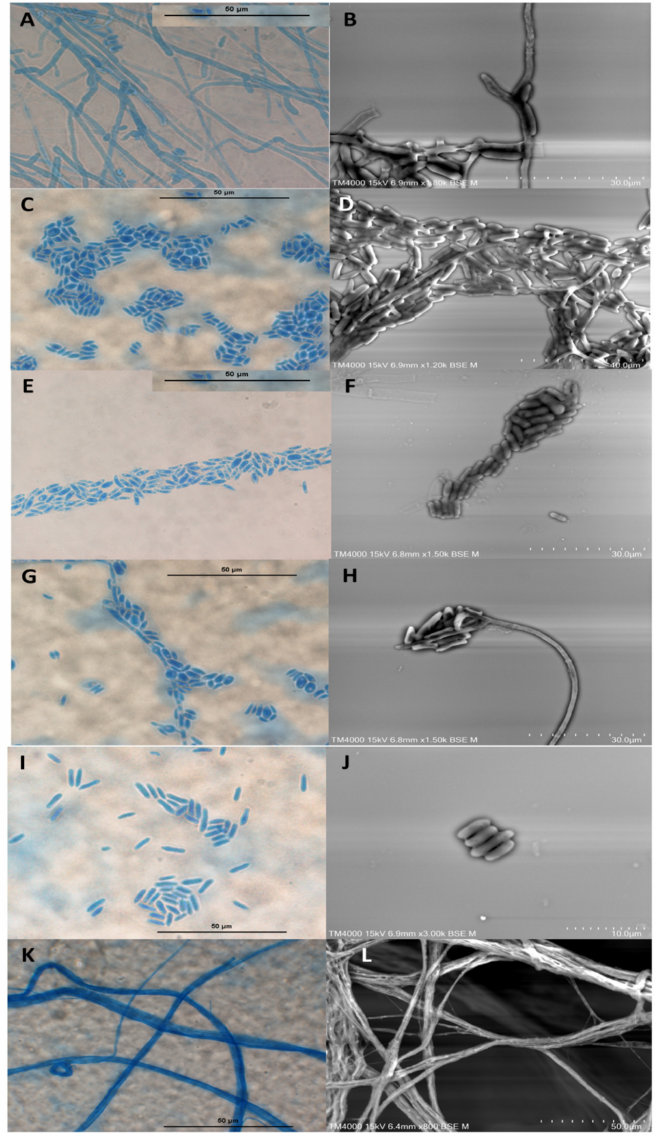
Figure 2. Morphology of Coniochaeta massiliensis (PMML0158). ( A , B ) Formation of conidiogenous cells (adelophialides) on hyphae and presence of collarette (arrow). ( C – F ) Conidia aggregating in clusters. ( G ) Conidia aggregating along the sides of the hyphae. ( H ) Phialoconidia assembled at the phialide tip. ( I , J ) Cylindrical conidia with thin and smooth walls. ( K , L ) Wide hyphae. Optical